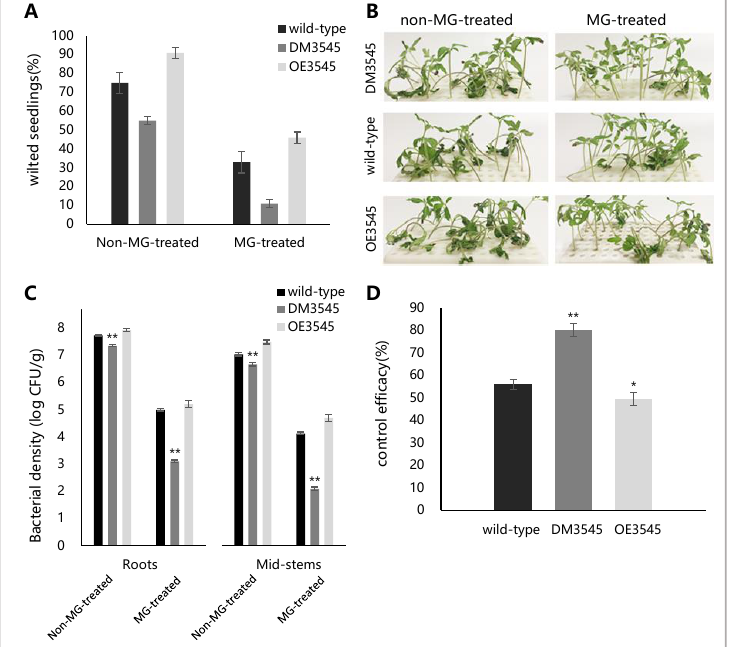
Figure 4. Determining the control effect of MG on bacterial wilt by seedling inoculation method. The figure marked with asterisks, indicating p < 0.01 (**) or p < 0.05 (*), was compared with the wild-type and statistically analyzed by analysis of variance (ANOVA) based on Fisher’s LSD test. ( A ) Wilting rate of plants at 9 DPI. ( B ) Growth of R. solanacearum -inoculated tomato seedlings at 9 DPI. ( C ) Bacterial population in roots and mid-stems at 9 DPI. The bacterial population (CFU/g of fresh weight) was log-transformed. ( D ) Control effect of MG against wild-type, DM3545 or OE3545 strain at 9 DPI.